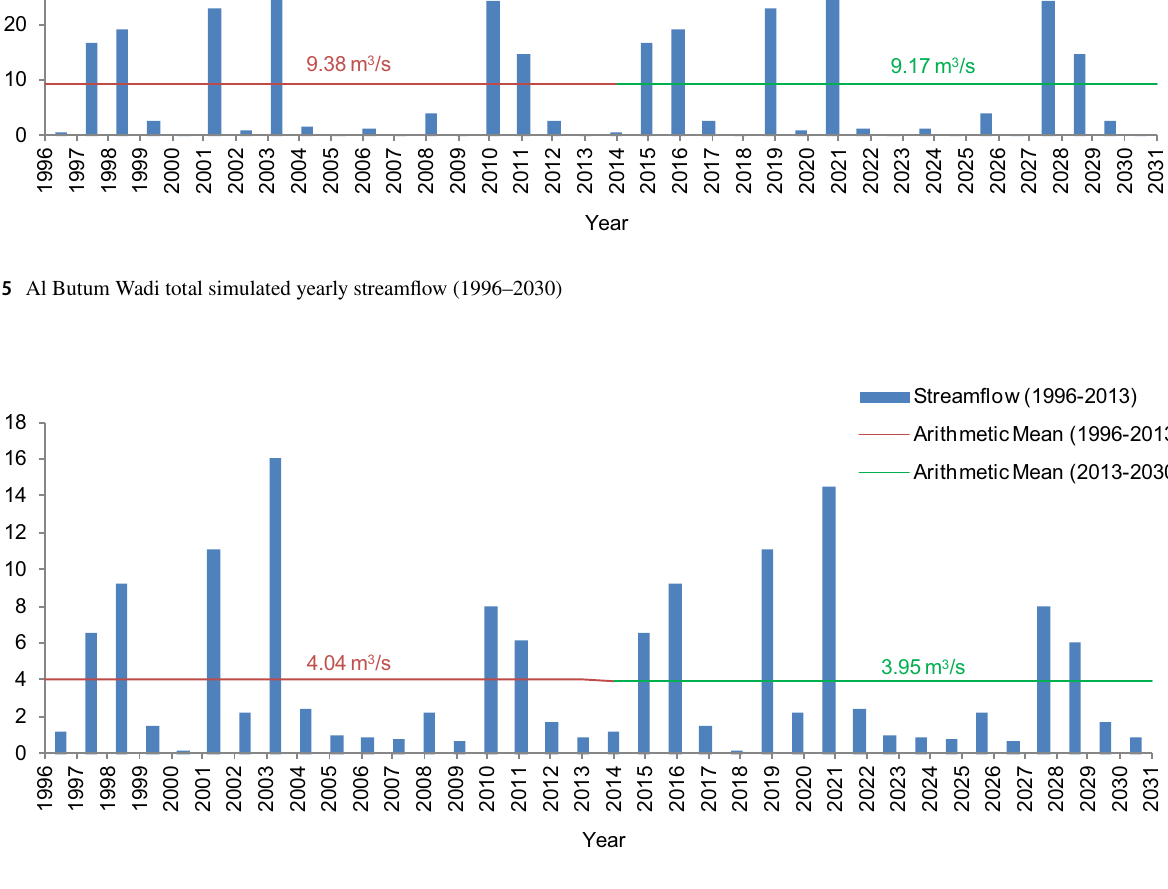
Fig. 16 El Janab Wadi total simulated yearly streamflow